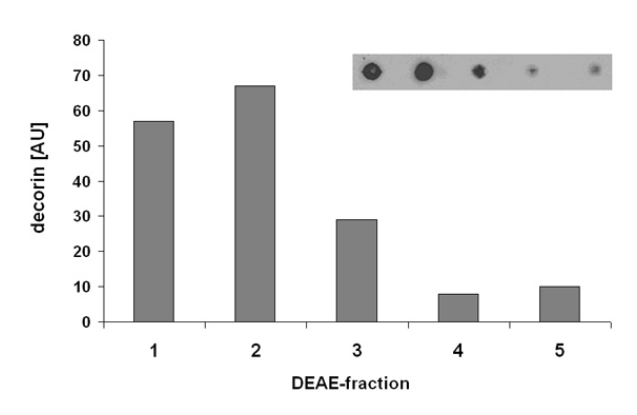
FIGURE 5. Fractionated elution profile of cross-linked decorin-receptor complexes subjected to DEAE-anion exchange chromatography. Human skin fibroblasts were incubated for 10 min at 37°C with btn-DCN-SASD. On photoactivation of the cross-linker, cells were immediately trypsinized and extracted with 1.5% ß-D-octylglucoside/4% CHAPS/1 m M PMSF/proteinase inhibitors in PBS. Subsequently, proteoglycans were purified from the cell extracts by DEAE-ion exchange chromatography on fractionated elution with the extraction buffer containing 1 M NaCl. 20-µl aliquots of the collected fractions were dotted onto a nitrocellulose membrane and biotinylated proteins were detected using peroxidase- conjugated extravidin followed by ECL (insert figure). The dot blot was scanned and analyzed semi-quantitatively using the Image J software (NIH, Bethesda, USA). Fractions 1–3 were pooled for further